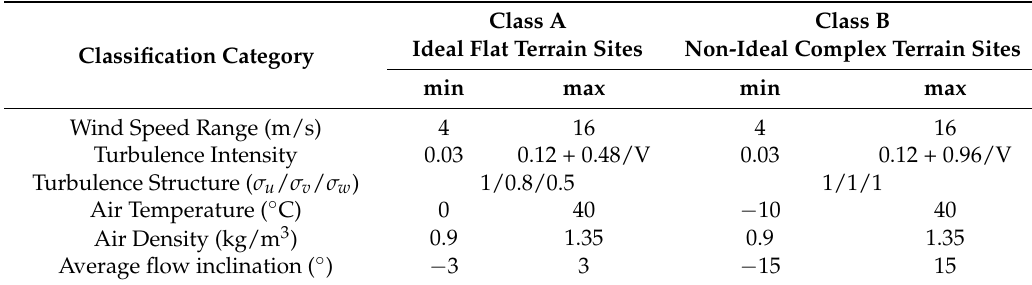
Table 1. Class A and Class B operational ranges.